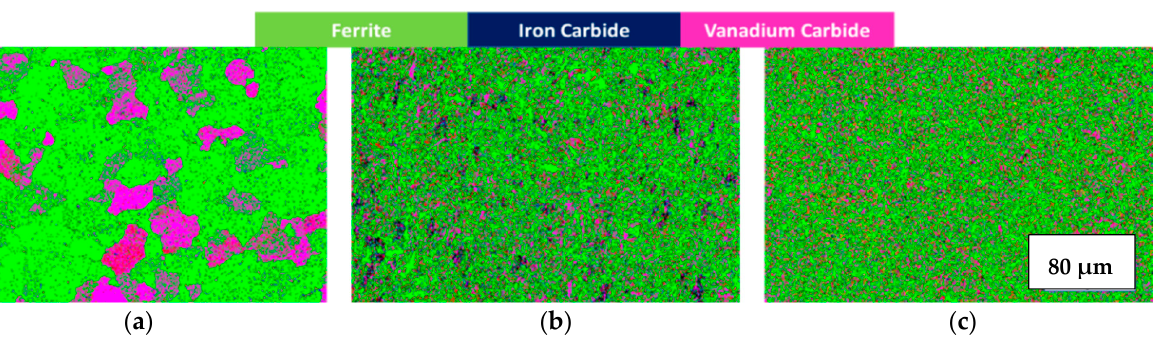
Materials 2021 , 14 , x FOR PEER REVIEW